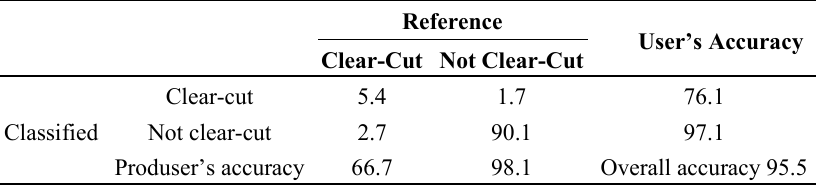
Table 2. Results with X-band SRTM at the stand level: Confusion matrix (%) of stand classification against the logging records. The classification threshold was − 7 m DSM change ( N = 3,181